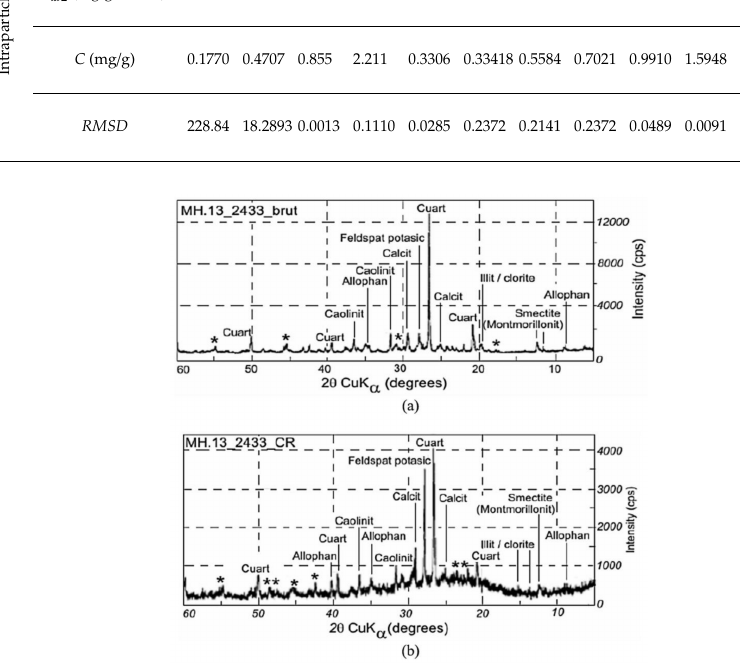
Figure 7. X-ray di ff raction spectra for soil sample MH-13 before ( a ) and after ( b ) CR sorption, (*) clay–humic complexes; (**) allophano–humic